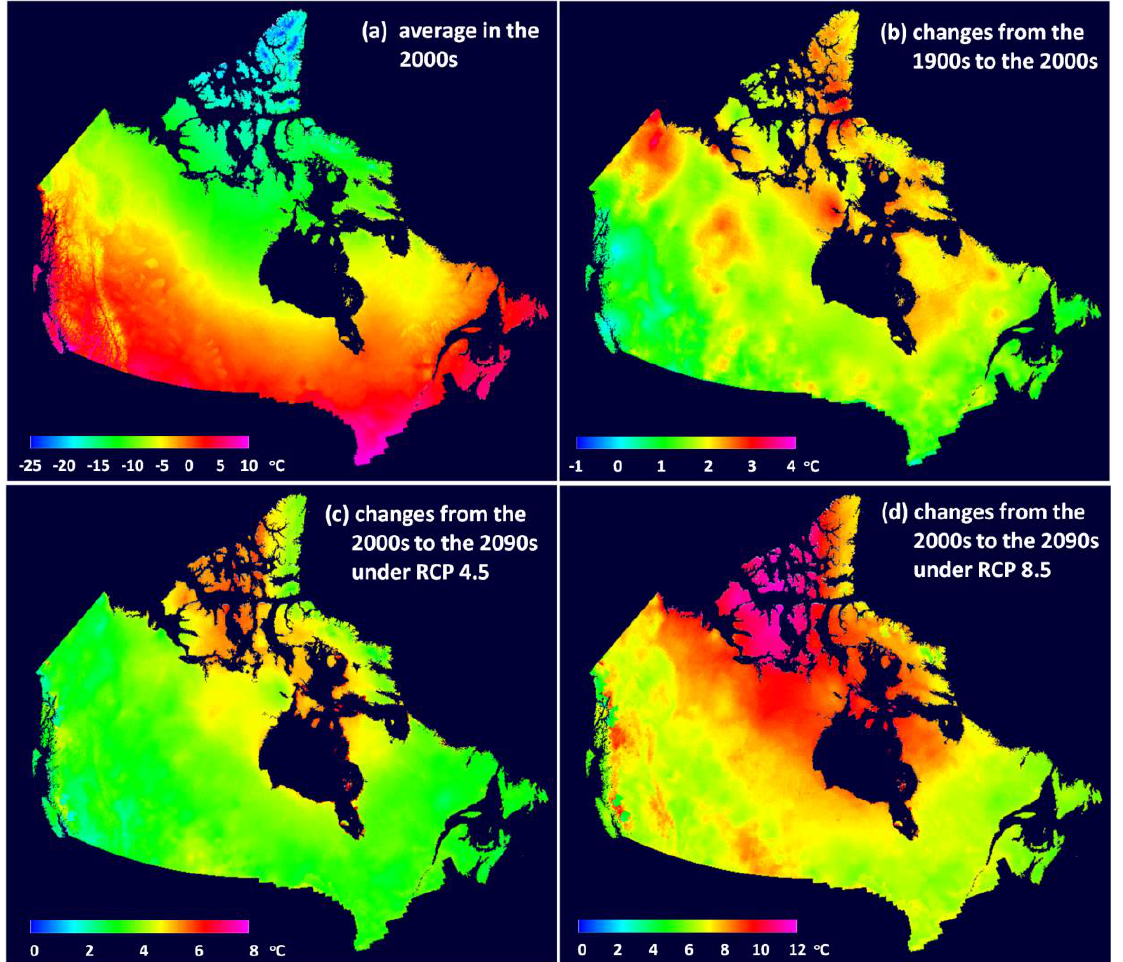
Figure 2. Spatial distributions of mean air temperature and changes with time generated by Met1km. ( a ) Mean air temperature in the 2000s (averaged from 2001 to 2010), ( b ) changes from the 1900s (averaged from 1901 to 1910) to the 2000s, and changes from the 2000s to the 2090s (averaged from 2091 to 2100) under scenarios of ( c ) RCP 4.5 and ( d ) RCP 8.5.